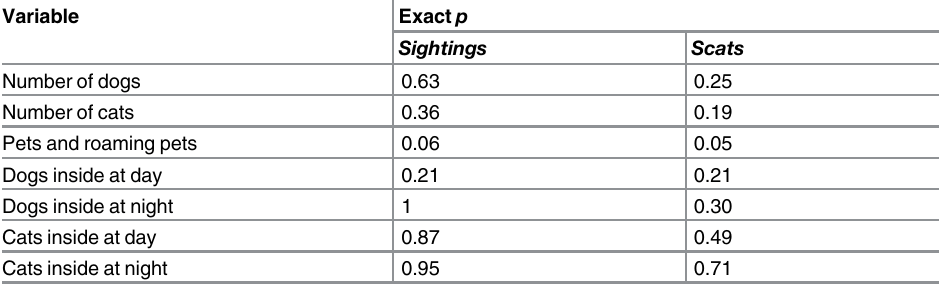
Table 1. Reports of bandicoot sightings or scats in regards to number of dogs/ cats, ownership of both pets, reports of roaming pets, or whether pets were kept inside at night or day. Results of the exact tests for each variable vs. each of the two measures (sightings and droppings) of bandicoot presence in backyards. Values are the exact probability (significance evaluated at α = 0.05) that each contingency table would occur if that particular combination of variables were